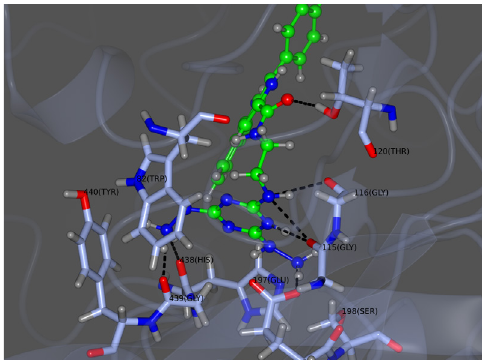
FIGURE 3 - Binding mode of 12 and BuChE. The compound is rendered in green ball-and-stick models, and the residues are rendered in grey coloured